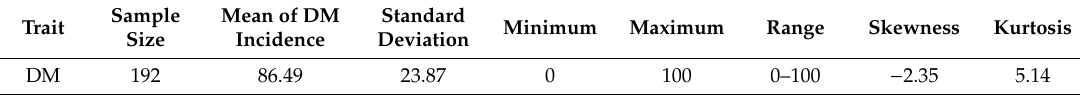
Table 2. Statistical data for DM experiments conducted in Phnom Penh, Cambodia in September 2017.